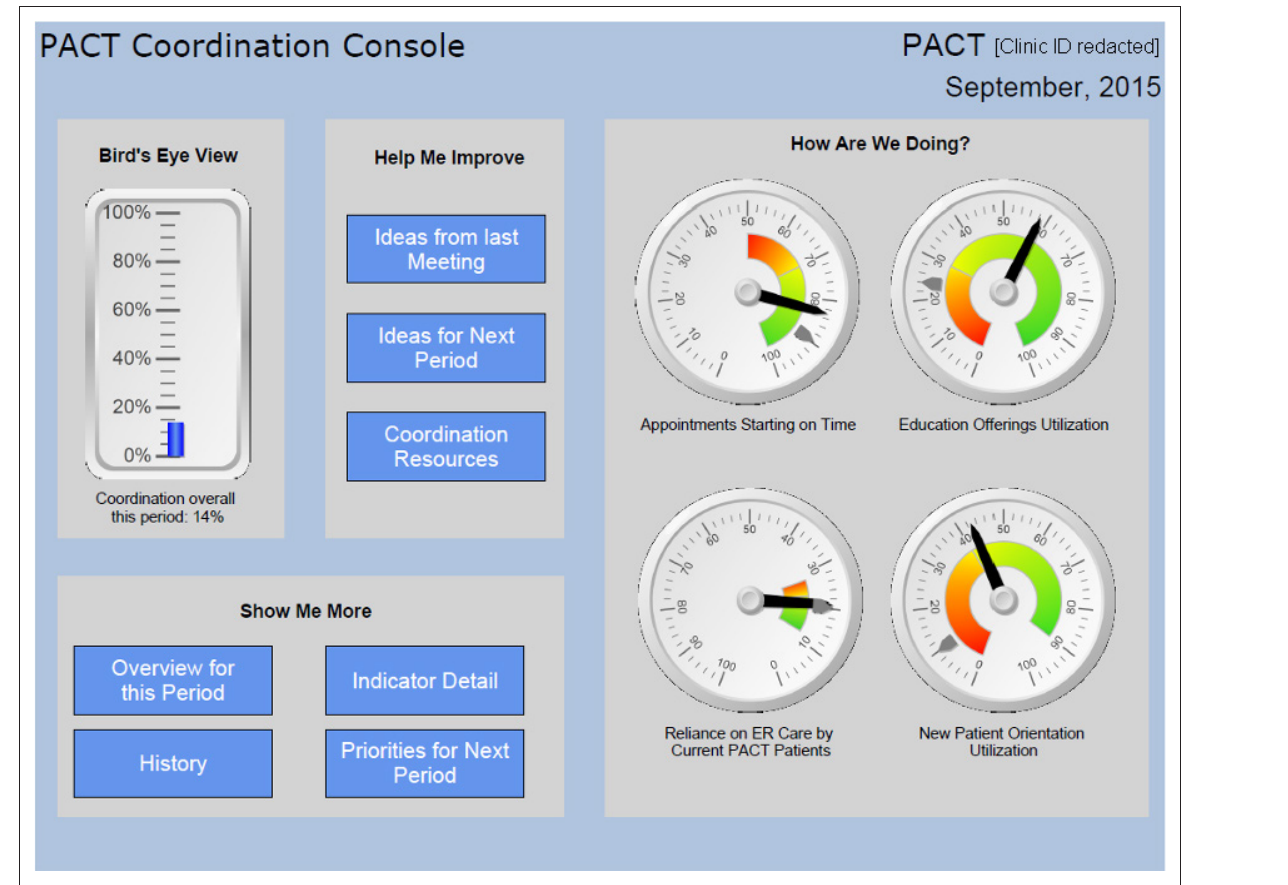
Figure 2 Screenshot of feedback report dashboard. ER = emergency room. PACT = Patient Aligned Care